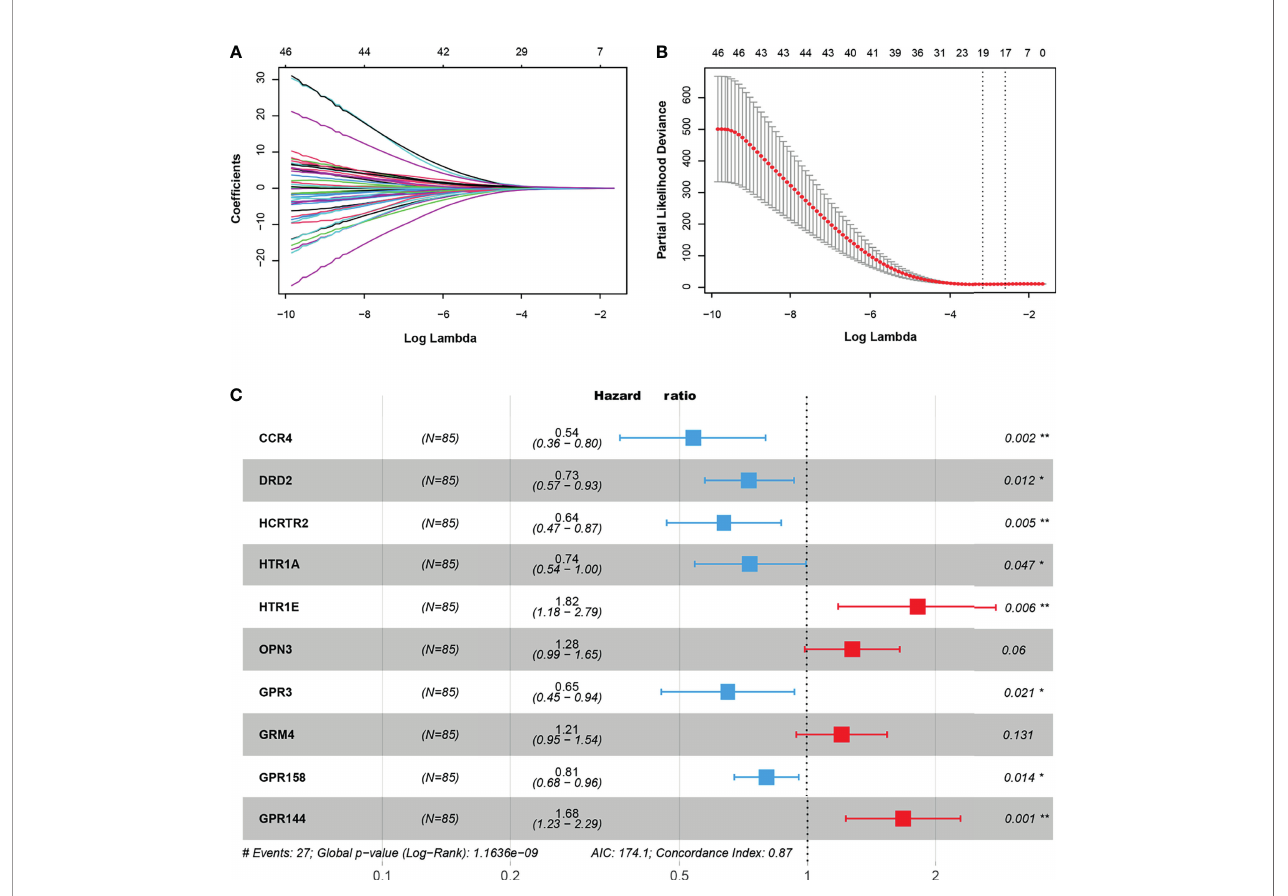
FIGURE 3 | (A) The trajectory of independent variables, the horizontal axis, and the vertical axis represent the logarithm of the independent variable lambda and the coef fi cient of the independent variable respectively. (B) The con fi dence interval under each lambda. (C) The key GPCRs used to build a risk model, hazard ratio (HR) < 0 indicated the hazard reduction, HR > 0 indicated the hazard increase. “ * ” represents 0.01 < p < 0.05, “ ** ” represents 0.001 < p <